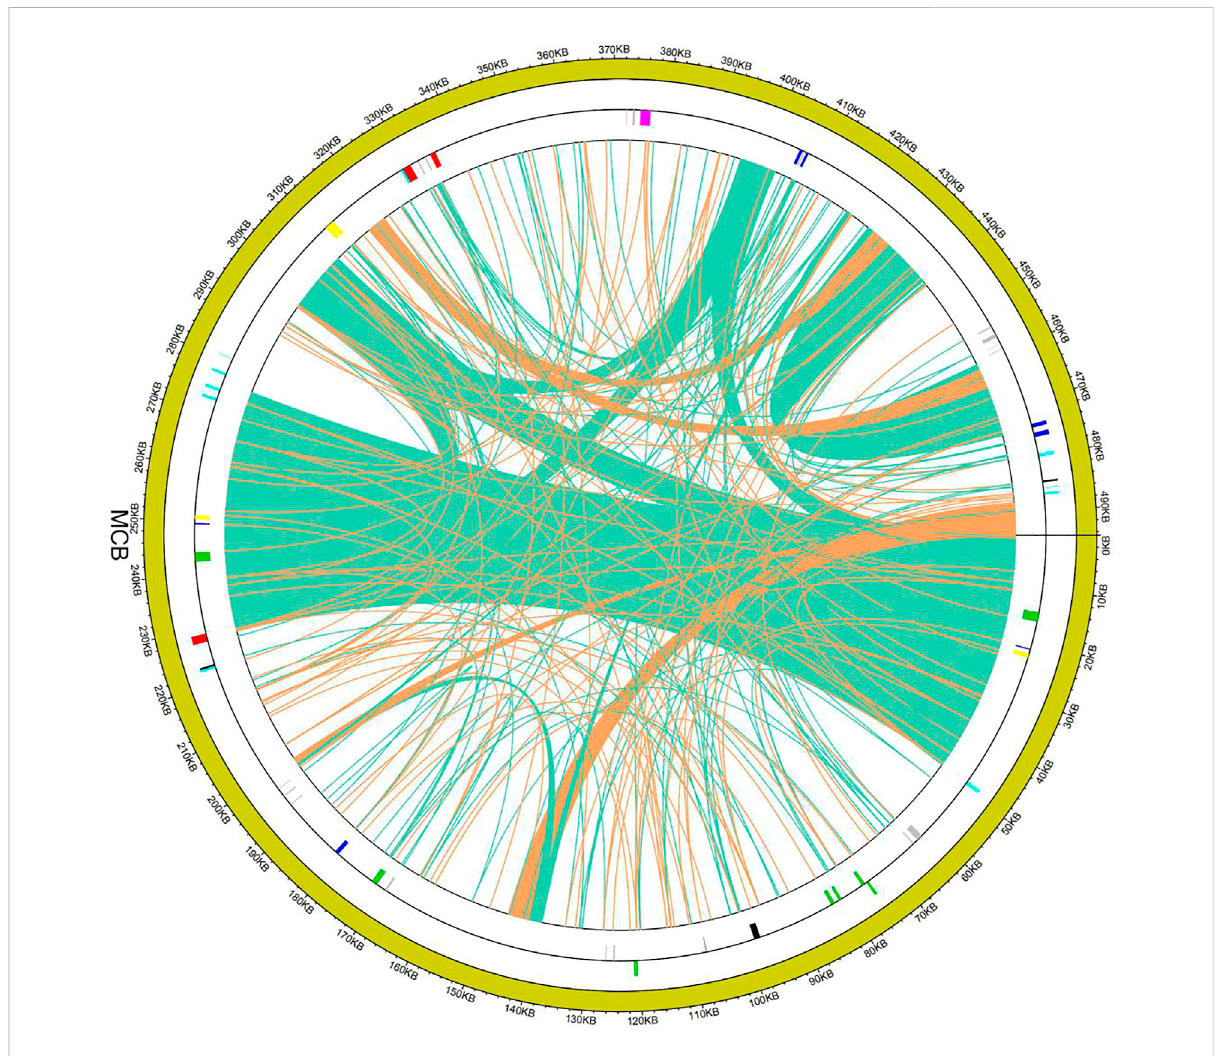
FIGURE 4 Distribution of repeat sequence in MCB